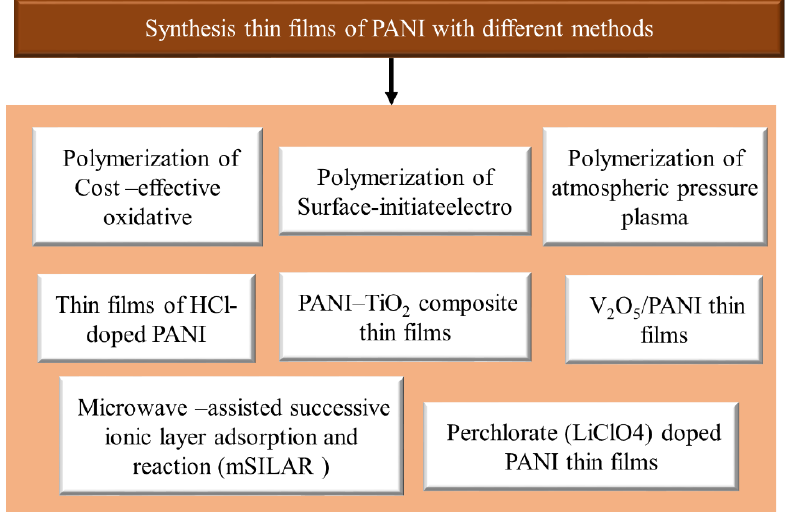
Figure 15. Synthesis of thin films of PANI via different methods.